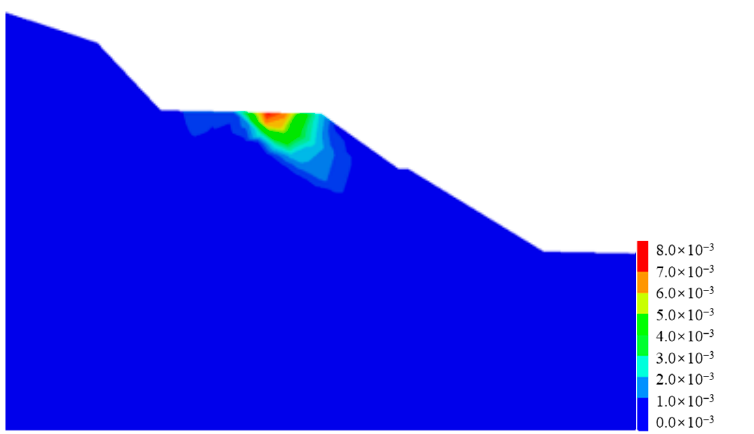
Figure 12. Plastic strain contour of the cut-and-fill subgrade after earthquake.